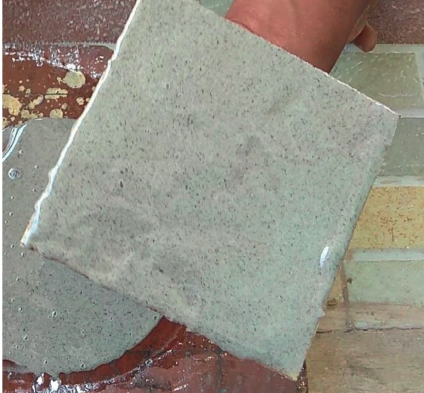
Figure 8: Material coated using the epoxy